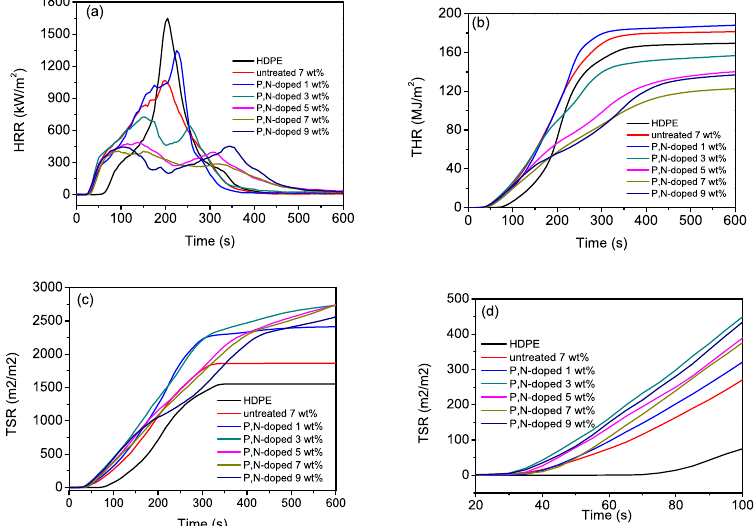
Figure 6. Cone calorimeter results of HDPE composites with untreated and P,N-doped cellulose: ( a ) HRR, ( b ) THR, ( c ) TSR, and ( d ) TSR curves within 20–100 s.